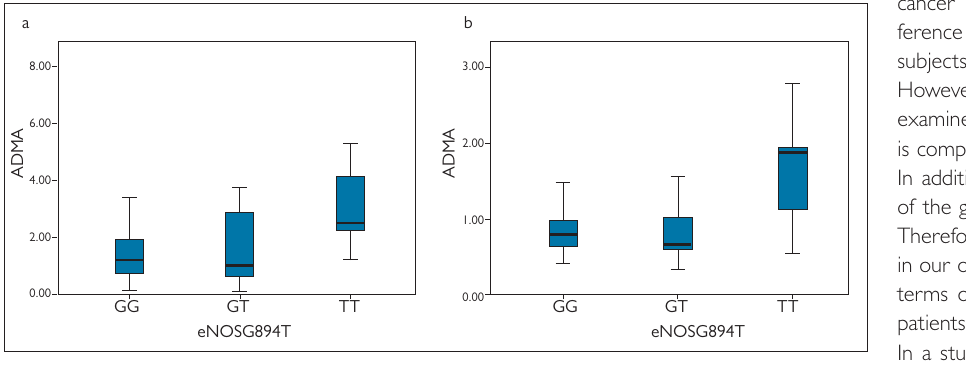
Figure 3. a, b. According to eNOS G894T polymorphisms, ADMA levels in patient (a) and healthy (b)